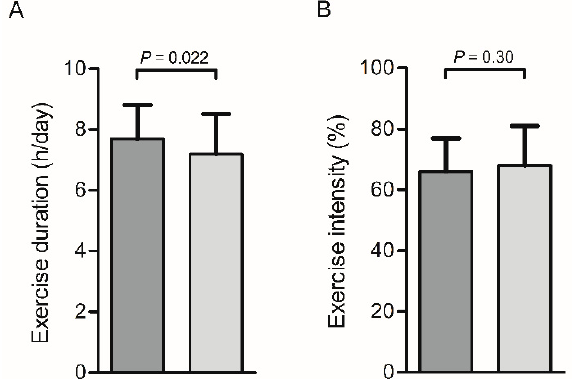
Figure 2. Bar charts for exercise duration (h / d) ( A ) and exercise intensity (% from HRmax) ( B ) on day 1. The exercise duration was 0.5 h longer for the protein group (dark grey) compared to the placebo group (light grey) ( p = 0.022), whereas no significant difference between groups was observed for exercise intensity (% from maximal heartrate (HRmax) ( p = 0.30).